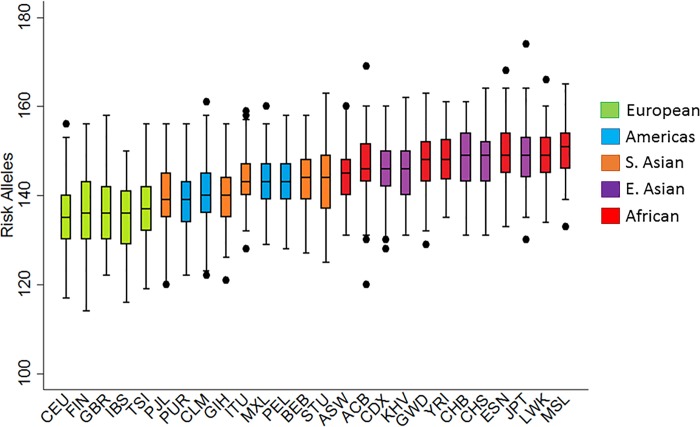
Distribution of fibroproliferative disease GRS in populations from 1000 Genomes.Results are sorted by median risk allele burden. Bars represent the 25th and 75th percentiles and are color coded by super-population (Green = EUR, Blue = AMR, Orange = SAS, Purple = EAS, Red = AFR).